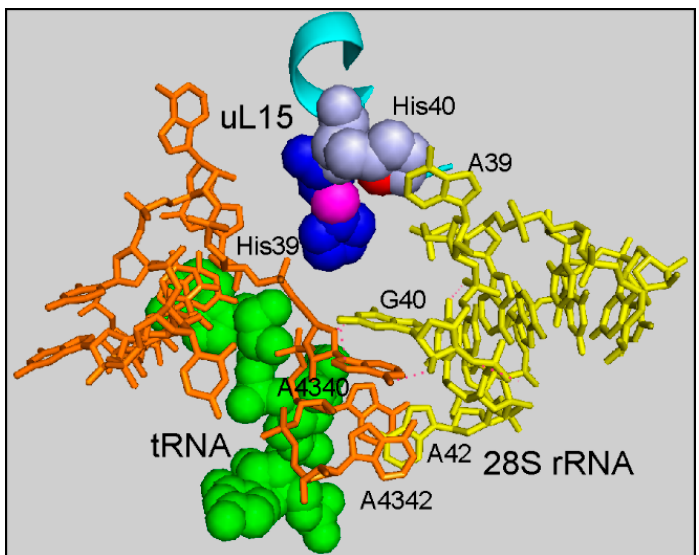
Figure 6. Fragment of the cryo-EM structure of the human ribosome around the residue His39 of uL15 (PDB: 6QZP, [29]). The nucleotides of the helices H11 and H82 of 28S rRNA are shown by sticks and are colored in yellow and orange, respectively. The CCA terminus of the E-site-bound tRNA is represented by green balls. Residues His39 and His40 of uL15 (cyan) are shown by blue and grey balls, respectively. The C β atom of His39 (magenta), which contains a hydroxyl group (not resolved in the structure), and the N δ atom (red) of His40, which possibly forms a hydrogen bond with the hydroxyl group at C β , as hypothesized in [22], stabilize the protein structure. Note the position of His39 within the E-site-bound tRNA environment. Figure drawn in the PyMOL Molecular Graphics System software [30].